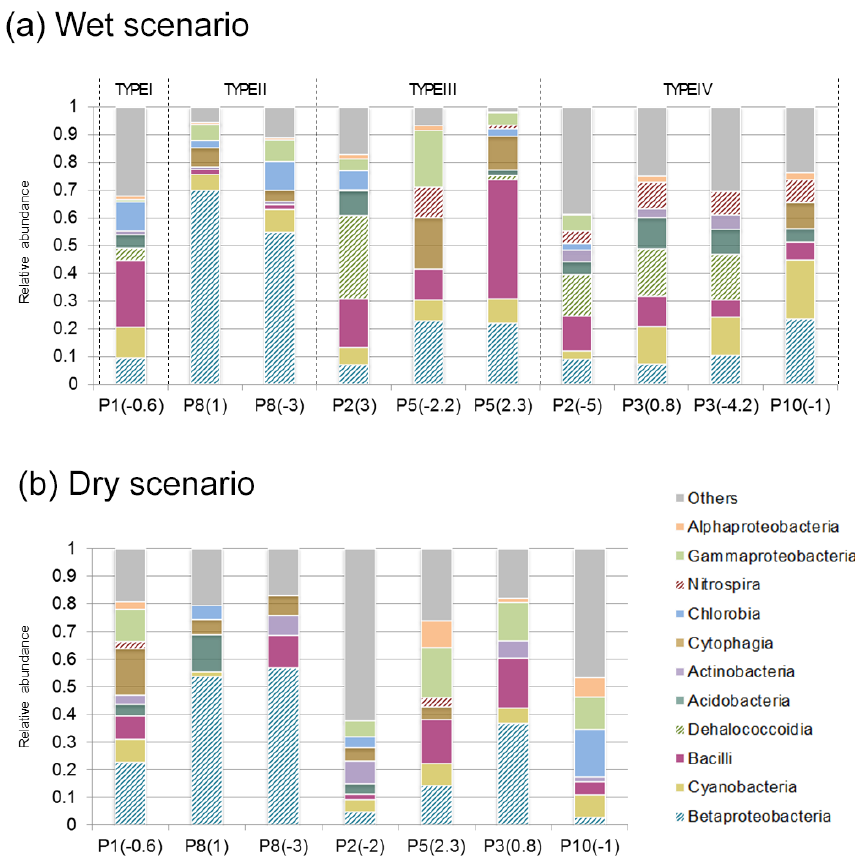
Figure 7. Bacterial community structure of groundwater samples. Class relative abundances calculated for wet (a) and dry (b) scenarios.